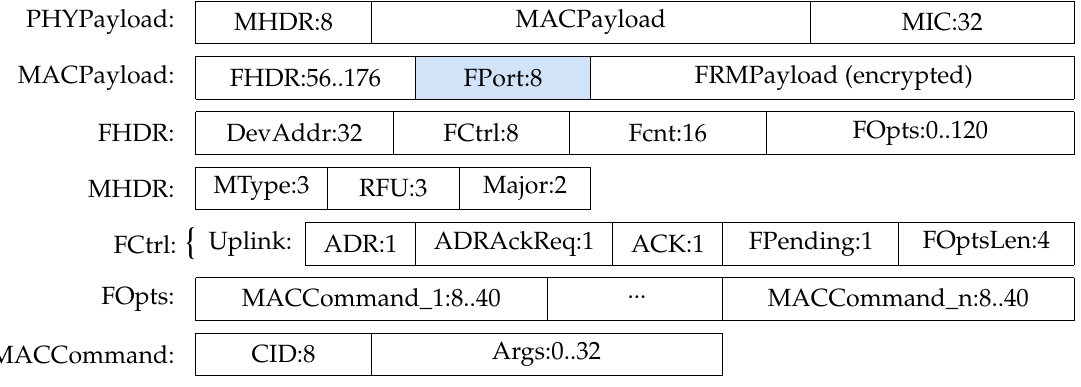
Figure 4. LoRaWAN frame